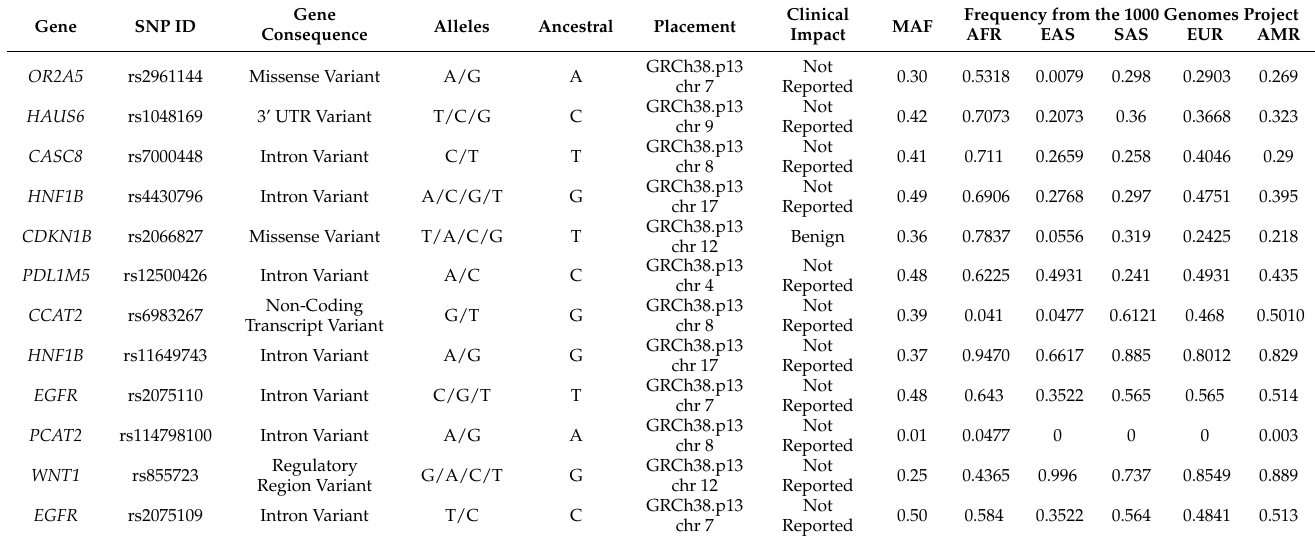
Table 1. SNPs significantly correlated with PCa mortality in different populations.